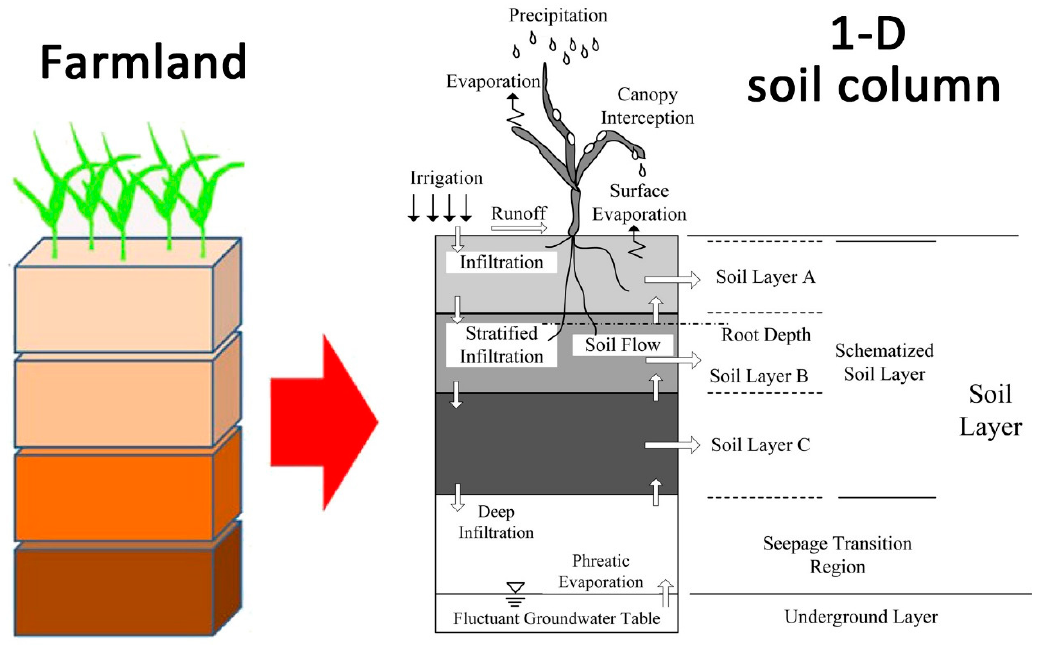
Figure 1. Hydrological processes in the 1D soil column method.